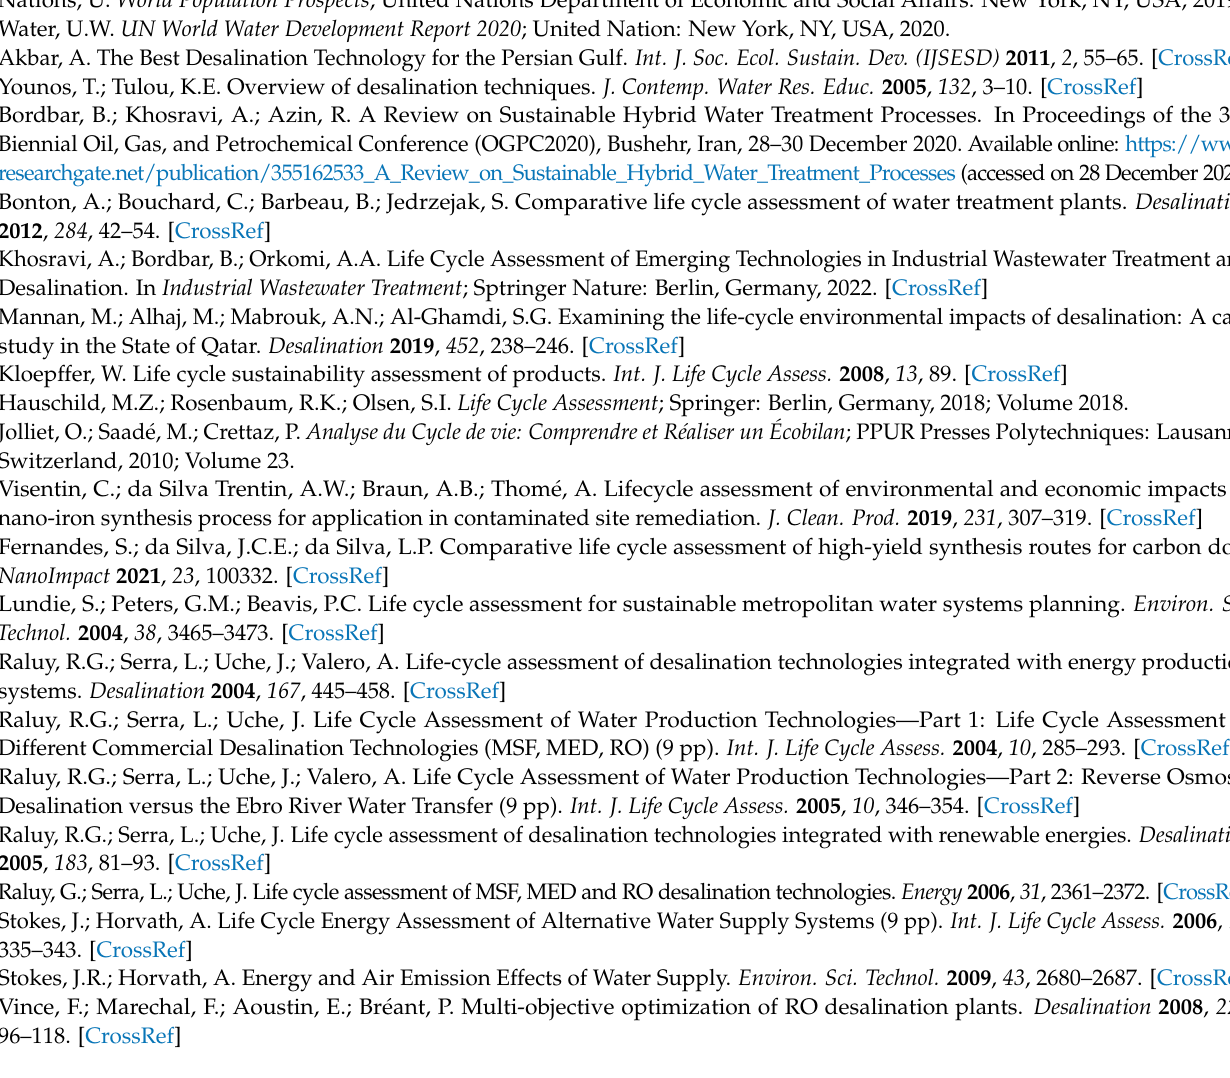
Table S2: Life cycle inventory of case 2, Table S3: Life cycle inventory of case 3, Table S4: Life cycle inventory of case 4, Table S5: Life cycle inventory of case